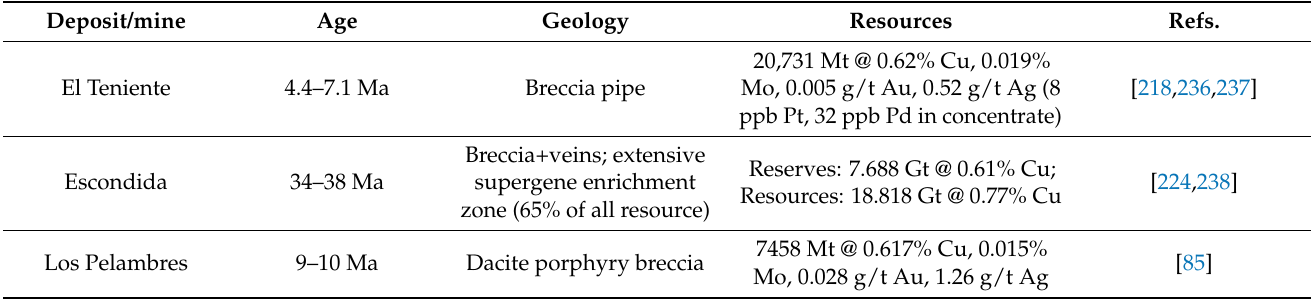
Figure 15. Distribution of Cu–Au porphyry and Au–Ag epithermal deposits associated with adakites and flat slab regions in the Andean magmatic arc. Tectonic framework of the Andean volcanic chain is modified from [217]. Location of adakite-hosted Cu–Au deposits is based on the geochemistry of magmatic rocks associated with porphyry and epithermal mineralization taken from the following sources [218–240] and shown separately in Figure 16. Table 9. Main characteristics of selected adakite-hosted Cu–Au deposits in the